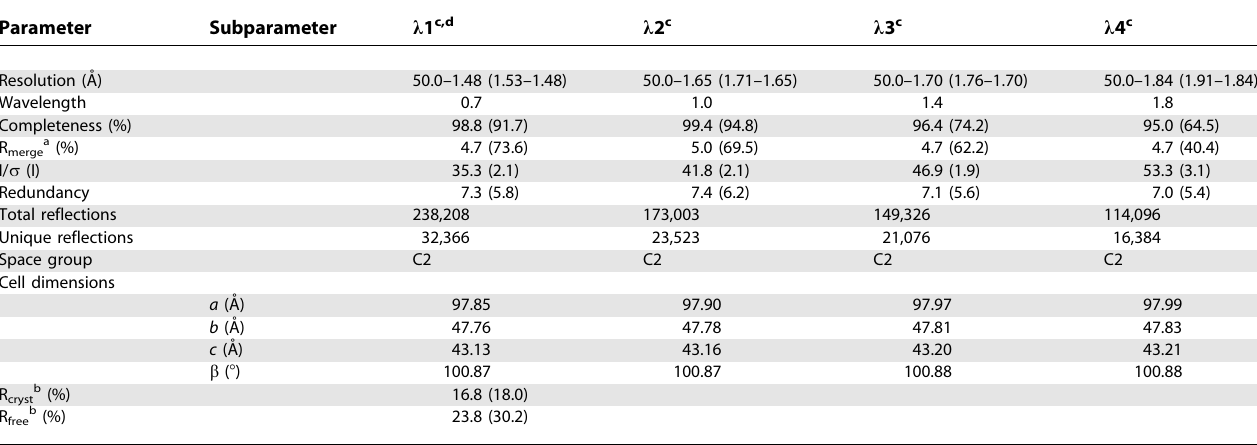
Table 1. Data Collection and Refinement Statistics